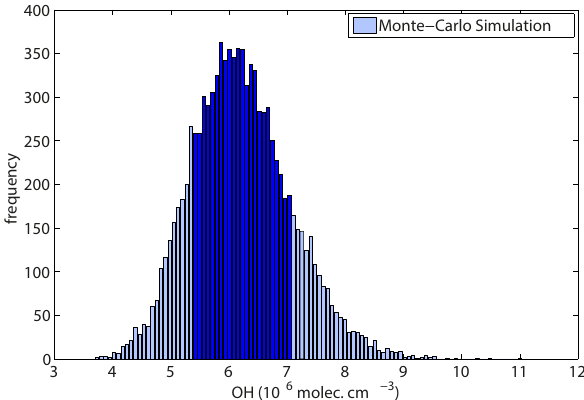
Figure 4. Histogram of the Monte Carlo simulation ( N = 9999) for the reaction rate coefficients on a single above-canopy data set in the early afternoon. The resulting distribution shows a slight skewness with a median of 6 . 15 × 10 6 moleccm − 3 and a mean of ( 6 . 21 ± 0 . 86 ) × 10 6 moleccm − 3 . The dark blue bars indicate the ± 1 σ